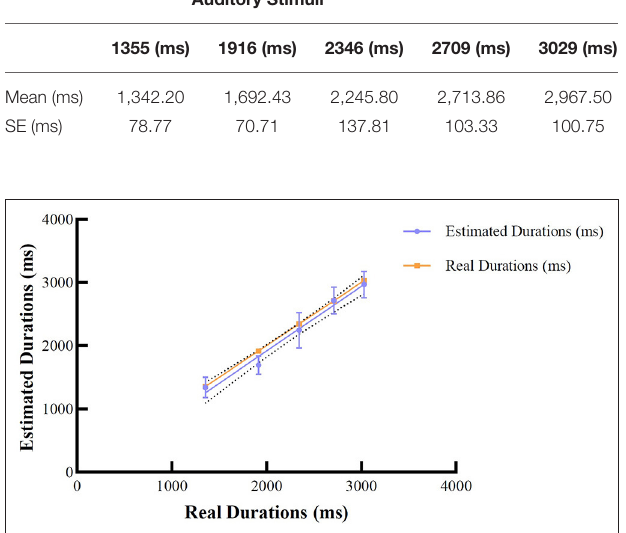
FIGURE 2 | Means for the estimated durations and real durations based on the law of free fall. Error bars represent 95%